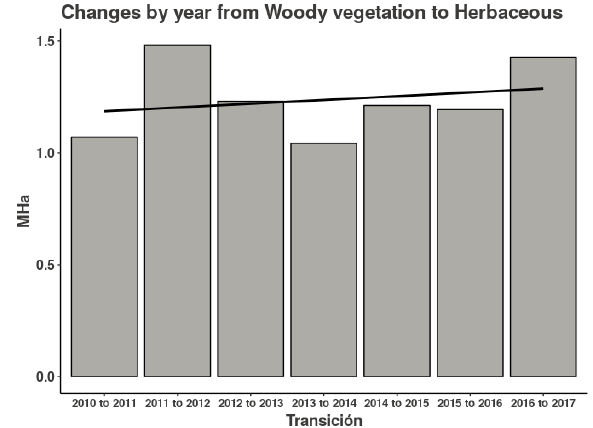
Figure 5. Annual transition between Woody vegetation and Herbaceous